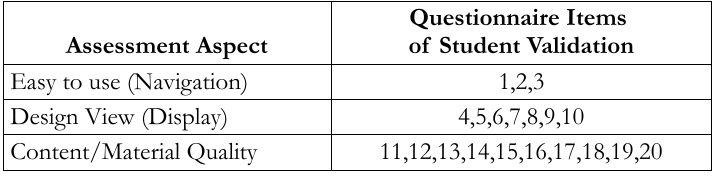
Table 2. Questionnaire of one try-out trial, Small group try-out, Field